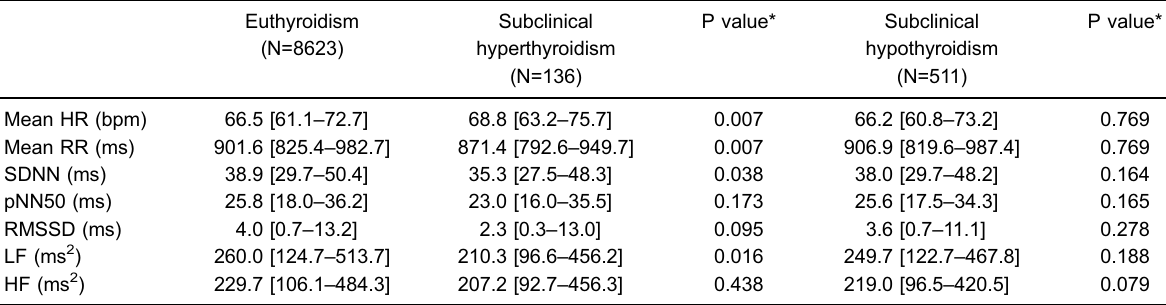
Table 2. Median and interquartile range of the characteristics associated with heart rate variability according to the presence of subclinical thyroid